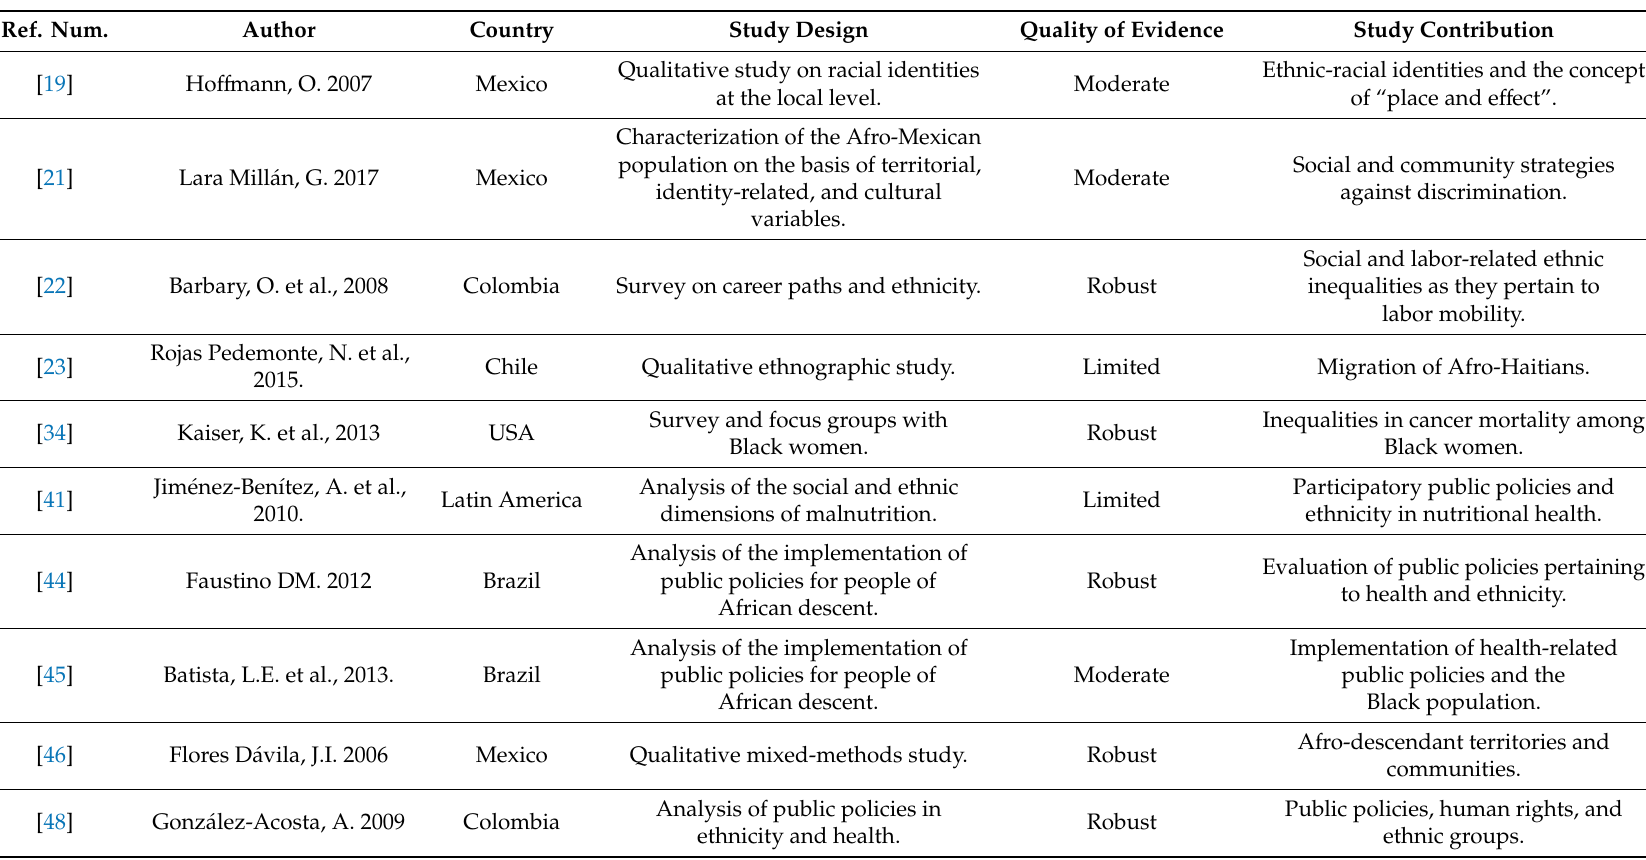
Table 7. Relevant qualitative studies and their contributions to understanding health inequalities among people of African descent in the Americas. Ref.